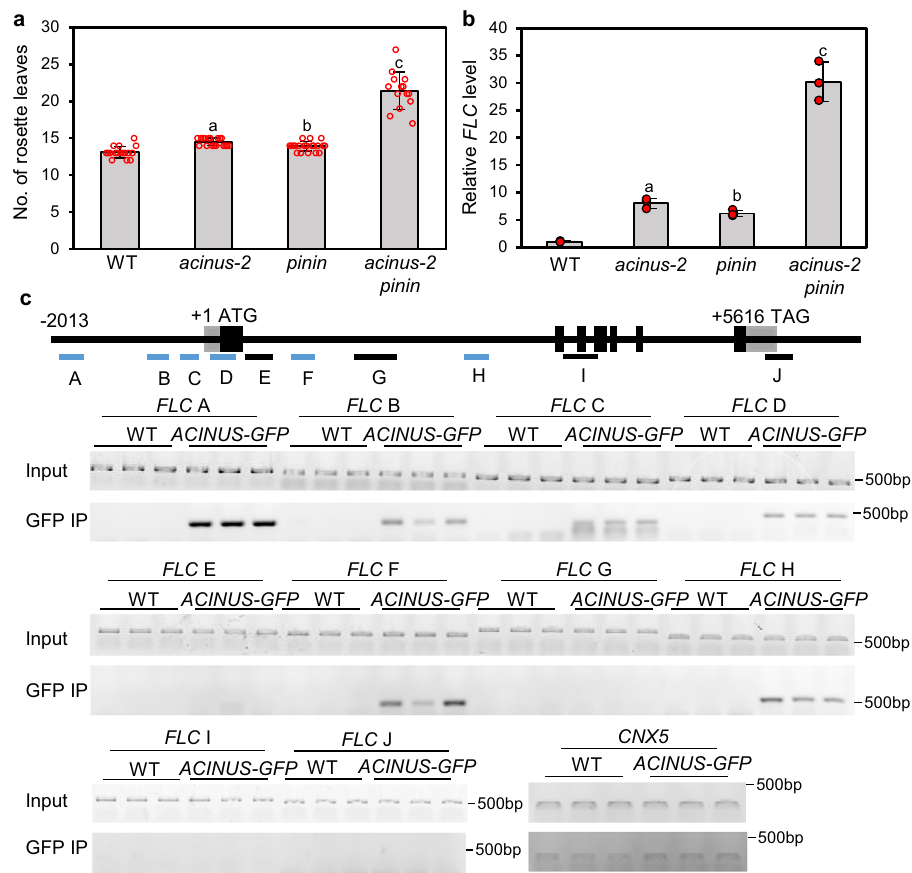
Fig. 5 The acinus-2 pinin-1 double mutant is late fl owering with increased FLC expression. a Rosette leaf numbers of WT, acinus-2 , pinin-1 , and acinus-2 pinin-1 at bolting stage grown in long day condition. Error bars indicate SD calculated from n >12. Values represent mean±SD calculated from at least 12 plants ( n >12). Statistically signi fi cant differences to WT were determined by two-tailed t test. The P values for a, b, and c are 1.35E − 6, 2.48E − 3, and 5.15E − 9. b FLC expression level relative to UBQ (At5g15400) in WT, acinus-2 , pinin-1 , and acinus-2 pinin-1 , determined by RT-qPCR in 12-day-old seedlings. Values represent mean±SD calculated from three biological replicates ( n = 3). Statistically signi fi cant differences to WT were determined by two-tailed t test. The P values for a, b, and c are 5.15E − 3, 3.32E − 3, and 4.91E − 3. c Analysis of AtACINUS-GFP association with the FLC locus by ChIP-PCR in 12-day-old AtACINUS-GFP/acinus-2 seedlings. WT serves as the negative control. Bars below the gene structure diagram represent regions analyzed by PCR (blue bars indicate regions enriched after immunoprecipitation). GFP IP shows PCR products using immunoprecipitated DNA. CO-FACTOR FOR NITRATE, REDUCTASE, AND XANTHINE DEHYDROGENASE 5 ( CNX5 ) serves as an internal control to show non-speci fi c background DNA after immunoprecipitation. PCR reactions were set to 28 The proteins co-immunoprecipitated with AtACINUS-GFP were